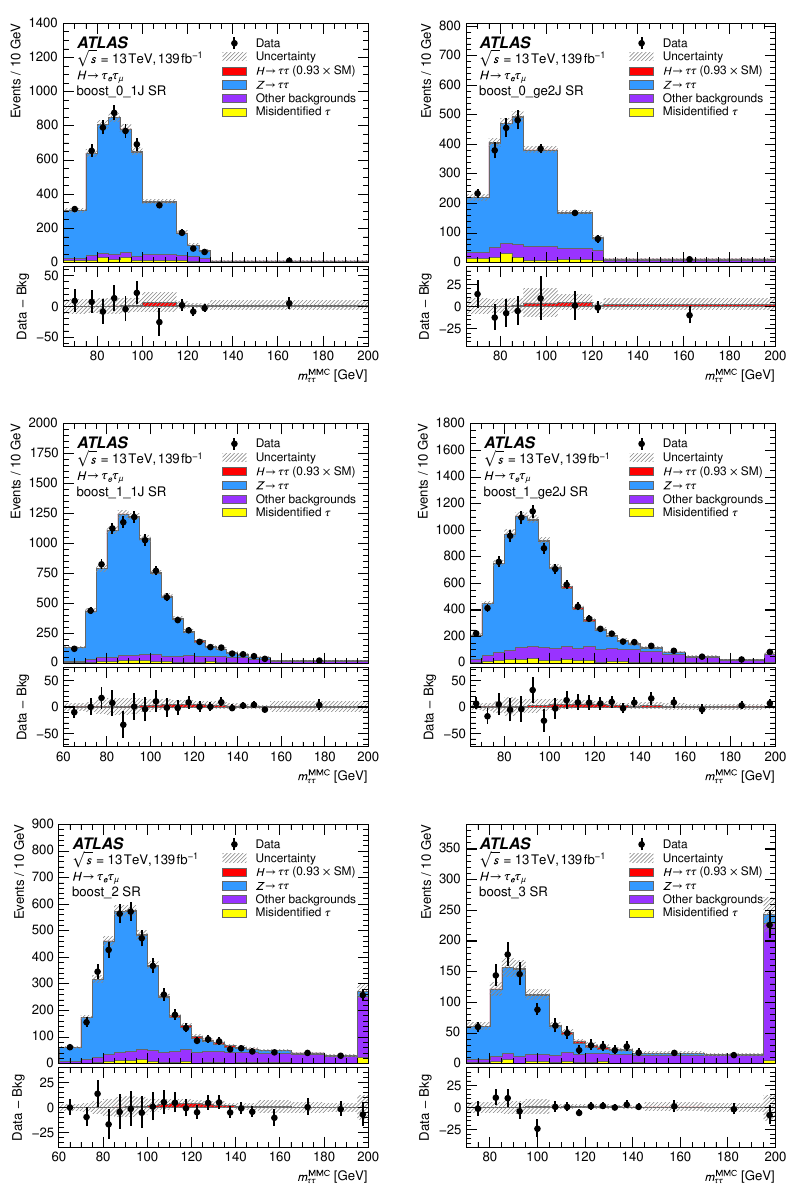
Figure 16. Distribution of the reconstructed ττ invariant mass ( m MMC ) for all events in the boost ττ categories of the τ τ channel. The bottom panel shows the differences between the numbers of e µ observed data events and expected background events (black points). The observed Higgs boson signal, corresponding to ( σ × B ) / ( σ × B ) = 0 . 93 , is shown with a filled red histogram. Entries SM with values above the x -axis range are shown in the last bin of each distributions. The dashed band indicates the total uncertainty on the total predicted yields. The prediction for each sample is determined from the likelihood fit performed to measure the pp → H → ττ